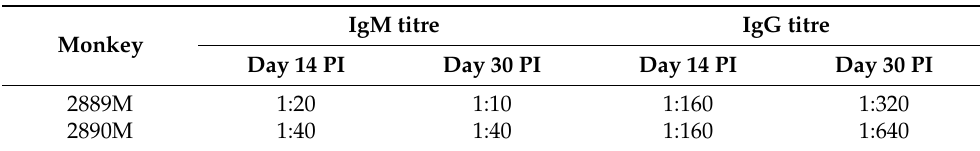
Table 3. The titre (unit in term of fold of dilution) of binding antibodies (IgM and IgG) from monkeys given intravenous EV71:TLL β P20. Titres were determined by indirect immunofluorescence using inhouse prepared EV-A71 subgenogroup B3 infected Vero cells as antigen.